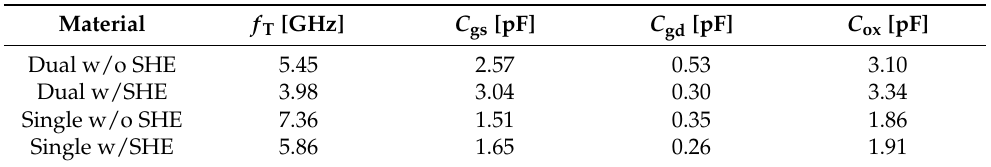
Table 2. Cut-off frequency, gate to source capacitance, gate to drain capacitance and gate oxide capacitance values calculated ( C ox = C gs + C gd ) according to whether SHE is applied or not in response to an AC signal is applied for recessed-gate GaN MOSFET with the stacked TiO 2 /Si 3 N 4 dual- and Si 3 N 4 single-layer